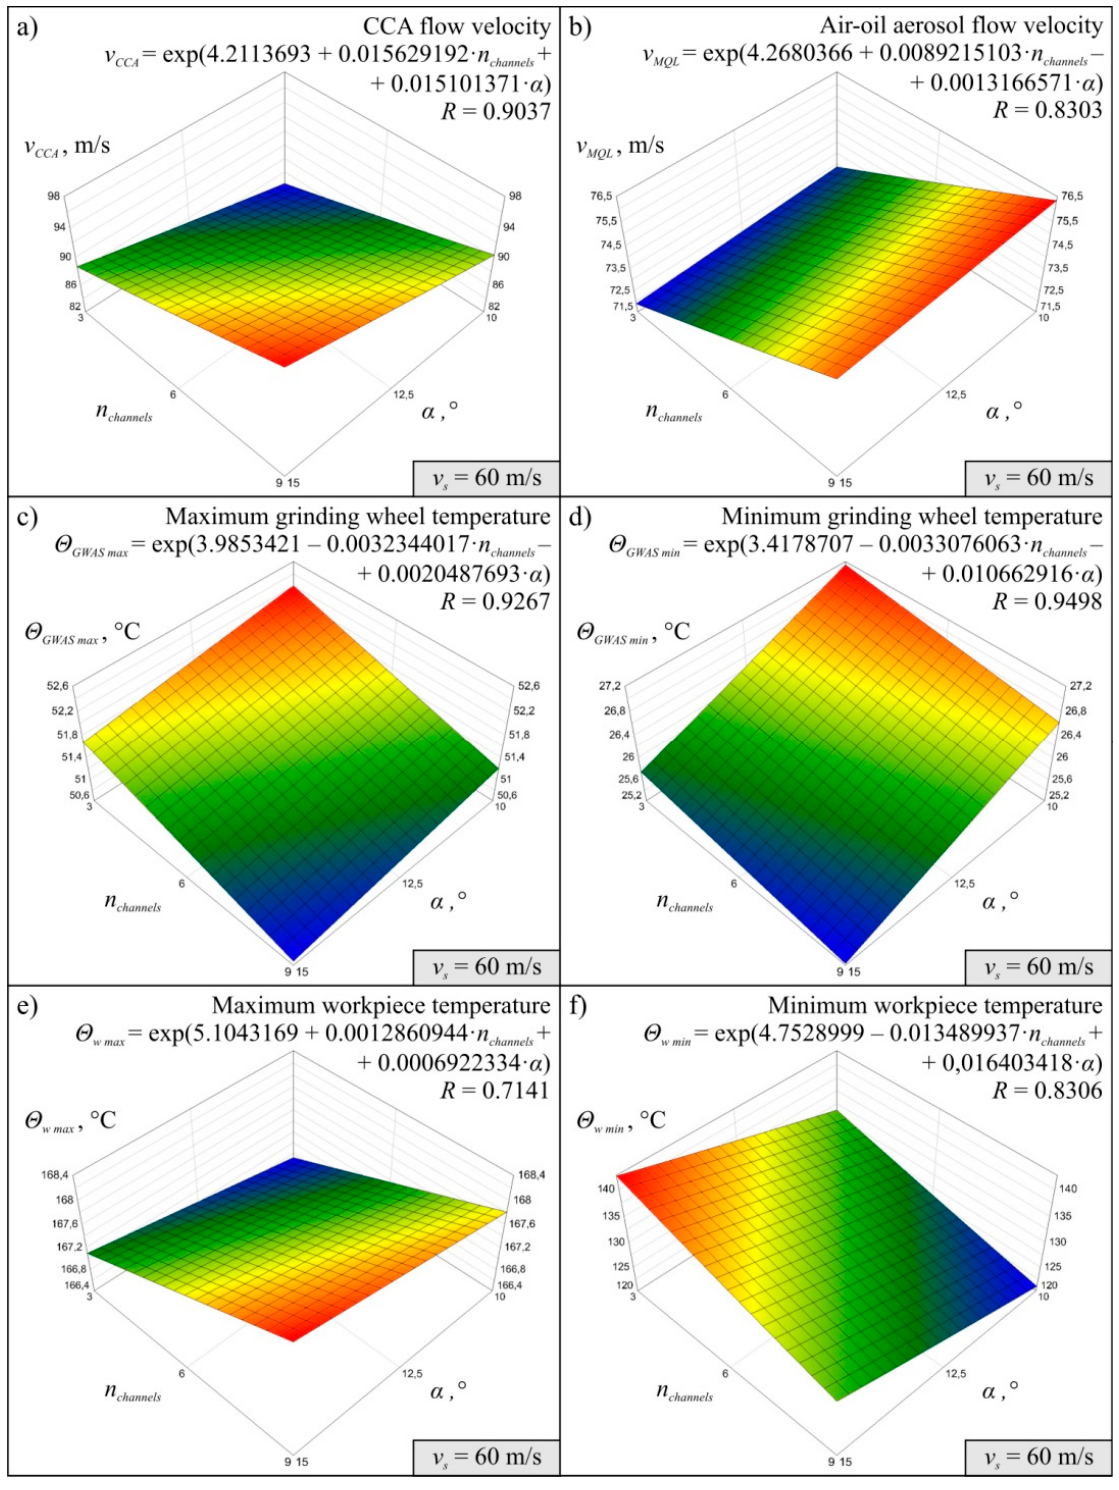
Figure 6. Mathematical models determined on the basis of simulation results for v s = 60 m/s: ( a ) v CCA ; ( b ) v MQL ; ( c ) Θ GWAS max ; ( d ) Θ GWAS min ; ( e ) Θ w max , ( f ) Θ w min.